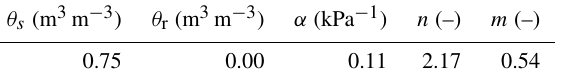
Table 4. Van Genuchten parameters (Eq. 1) fitted to the curve BCD shown in Fig. 10a: saturated volumetric water content, θ s ; residual volumetric water content, θ r ; and parameters, α , n , and m .